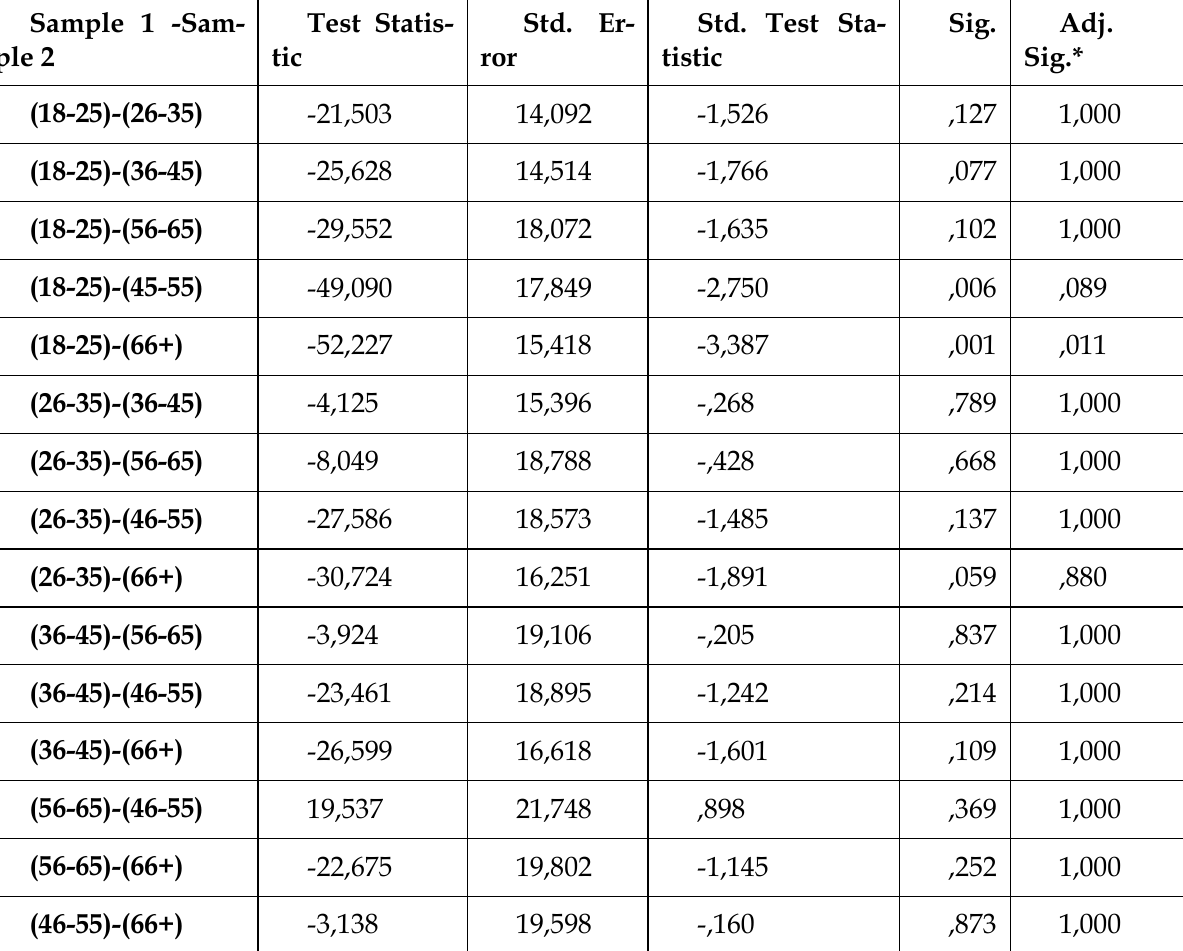
Table 15. Trust towards the health Centre and age. Pairwise comparison (Bonferroni). Each row tests the null hypothesis that the Sample 1 and Sample 2 distributions are the same. Asymptotic significances (2-sided tests) are displayed. *Significance values have been adjusted by the Bonferroni correction for multiple